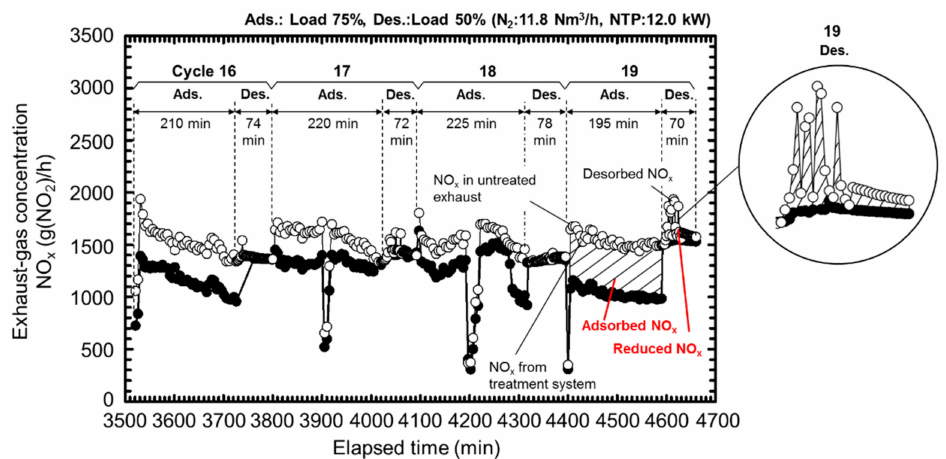
Figure 7. Time-dependent NO x emissions before and after the gas passes through the aftertreatment for operation cycles